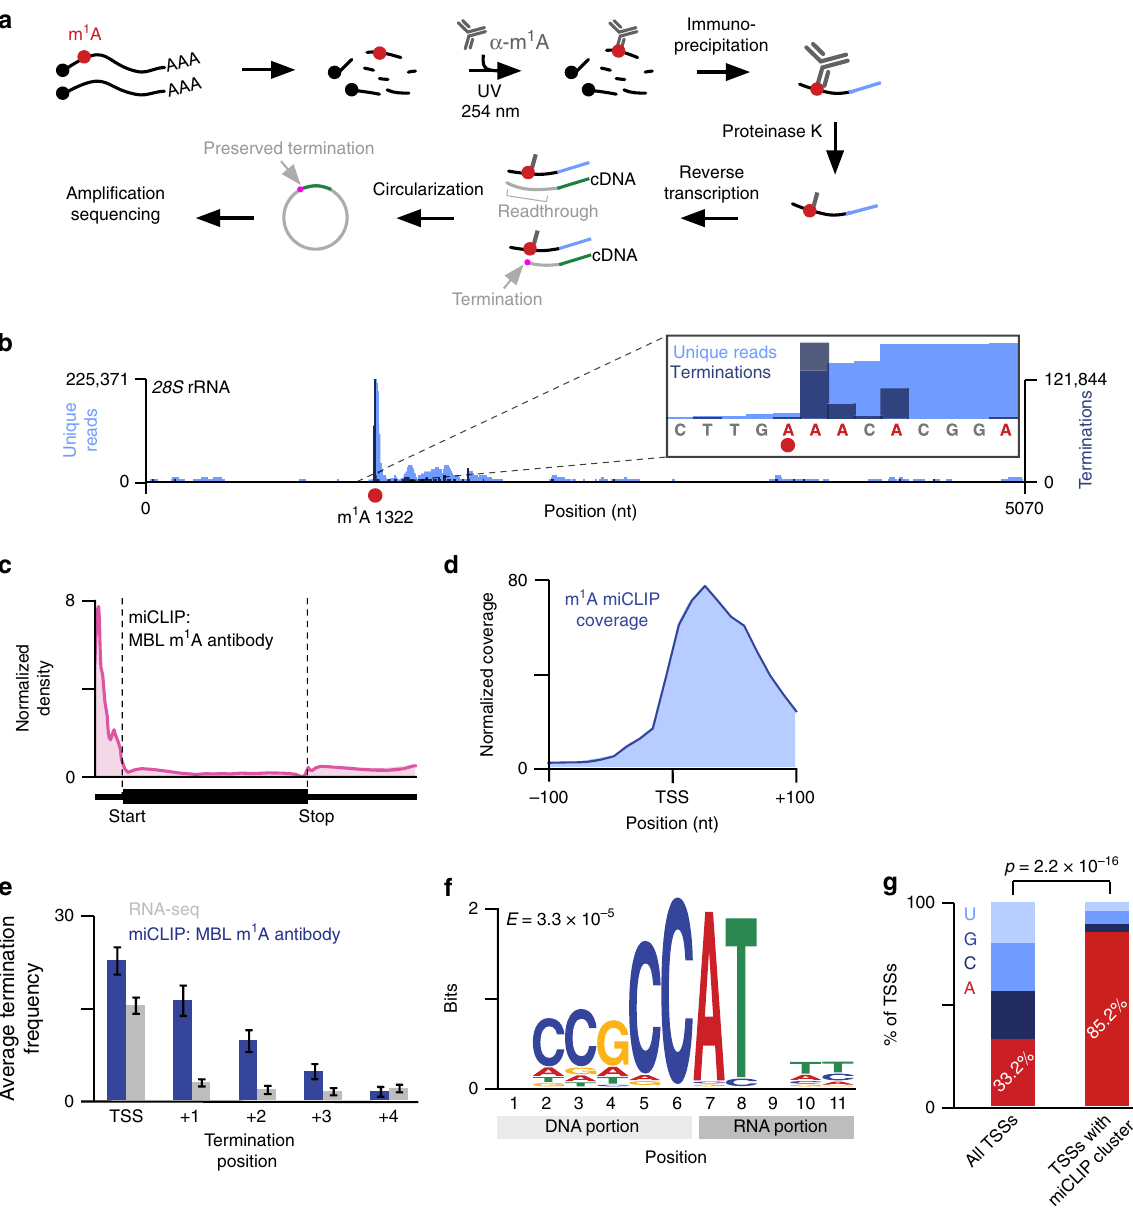
Fig. 2 Mapping m 1 A in the transcriptome using m 1 A-miCLIP. a m 1 A-miCLIP work fl ow. Poly(A) RNA (black lines; black circles, RNA caps) was fragmented, incubated with m 1 A antibody, and crosslinked to the antibody with UV. RNA-antibody complexes were immunoprecipitated, ligated to a 3 ′ linker (blue line), and puri fi ed. RNA was released from crosslinked antibody using Proteinase K, generating RNA fragments with peptide adducts. After reverse transcription, fi rst-strand cDNA (gray lines) was circularized to preserve m 1 A-induced read terminations (magenta dot) at the cDNA 3 ′ end. b m 1 A-miCLIP detects the known m 1 A site in the 28S rRNA. m 1 A-miCLIP unique reads (light blue) were aligned to rRNA showing high enrichment at the m 1 A site (red circle) at position 1322 of the 28S rRNA. The reads terminated predominantly at the + 1 position relative to m 1 A (inset, dark blue). c Relative distribution of m 1 A-miCLIP clusters. The metagene distribution of m 1 A-miCLIP clusters that contained 20 or more stacked reads ( n = 3877) was normalized to RNA-seq coverage and plotted. Clusters were predominantly enriched in the 5 ′ UTR and next to the transcription-start site (start, start codon; stop, stop codon). The annotation of transcription-start sites is not exact, which results in slight coverage upstream of the transcription-start site. d m 1 A-miCLIP coverage is enriched at and near transcription-start sites. m 1 A-miCLIP unique reads were mapped relative to annotated transcription-start sites using Deeptools (see Methods). e While RNA-seq reads terminate predominantly at position 0 (i.e. due to the end of the transcript), m 1 A-miCLIP reads terminate predominantly at positions 0 and + 1, and to a lesser degree, at downstream nucleotides, suggesting that the m 1 A antibody binds at or near the transcription-start site and blocks reverse transcription. Error bars represent SEM. Source data are provided as a Source Data fi le. f m 1 A-miCLIP clusters found in 5 ′ UTRs showed signi fi cant enrichment of the pyrimidine-rich Initiator sequence motif that facilitates transcription initiation of mRNAs at adenosine ( E = 3.3 × 10 − 5 ). g m 1 A-miCLIP clusters were overlapped with a collective set of transcription-start sites (TSS) that included RefSeq annotations and m 6 A m mRNA extended caps 44 . While 33.2% of these collective transcription-start sites were adenosines, the frequency of adenosine transcription-start sites overlapping m 1 A- miCLIP clusters was signi fi cantly higher (85.2%, n = 1,026 TSSs, p < 2.2 × 10 -16 , Fisher ’ s exact